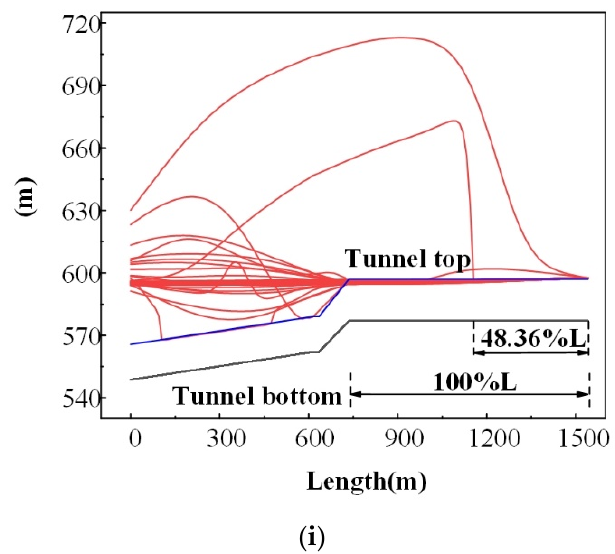
Figure 4. Water level with a vent at different positions: ( a ) 6.25%L, ( b ) 18.75%L, ( c ) 31.25%L, ( d ) 43.75%L, ( e ) 56.25%L, ( f ) 68.75%L, ( g ) 81.25%L, ( h ) 93.75%L, and ( i ) no vent.